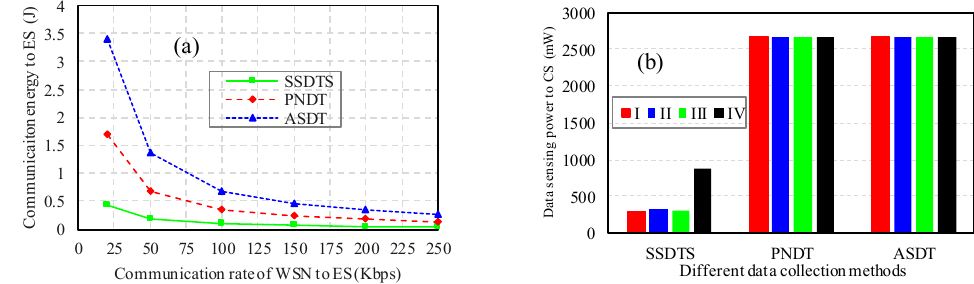
Figure 10. ( a ) Communication energy consumption of the edge server (ES) at different communication rates, ( b ) Sensing power of the cloud server (CS) of different methods.